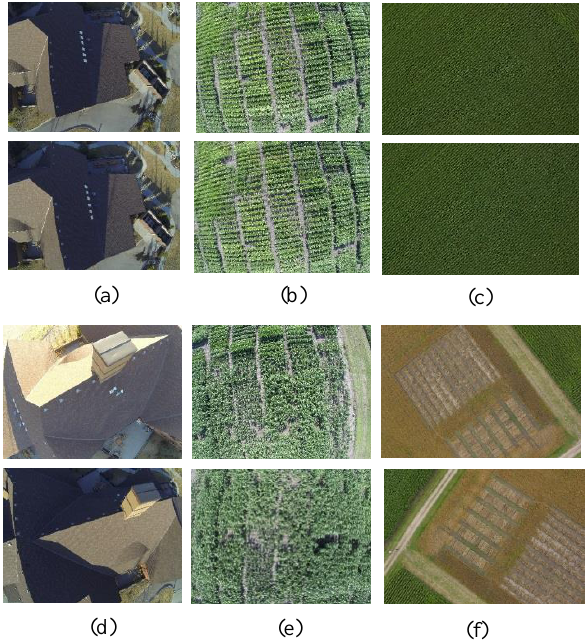
Figure 2. (a – c) Stereo-pairs with baseline aligned along the flight direction in Datasets 1 – 3, and (d – f) stereo-pairs with baseline aligned across the flight direction from Datasets 1 –